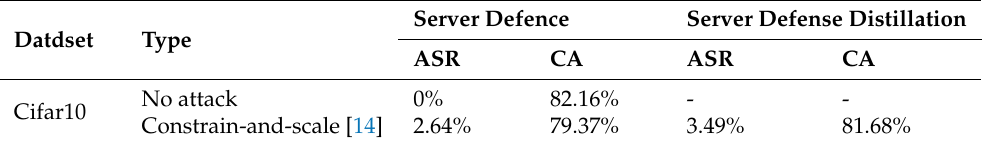
Table 4. Global Model Only